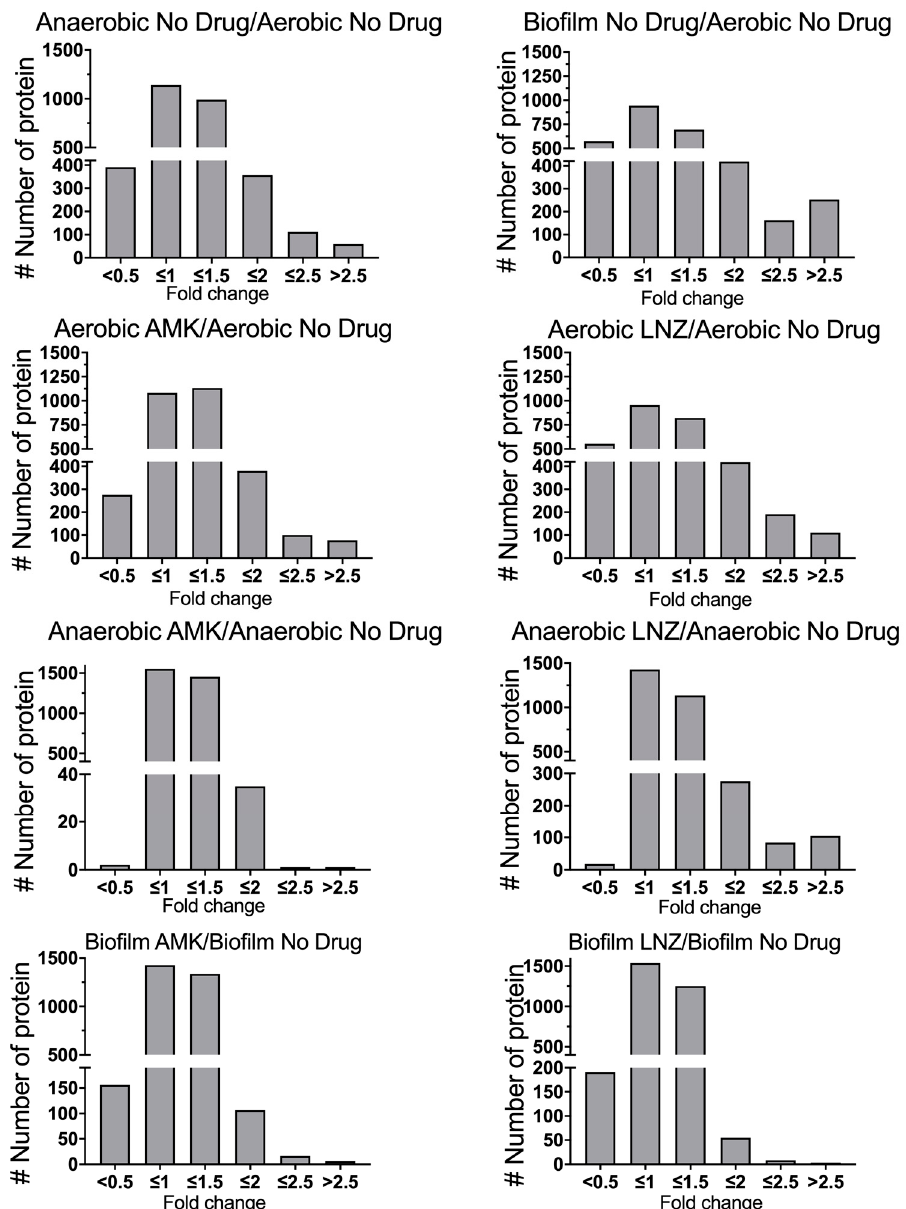
Figure 3. Fold changes of differentially expressed MAB proteins. The histograms demonstrate the distributions of fold changes of differentially expressed proteins in anaerobic and biofilm conditions with and without AMK and LNZ treatments.